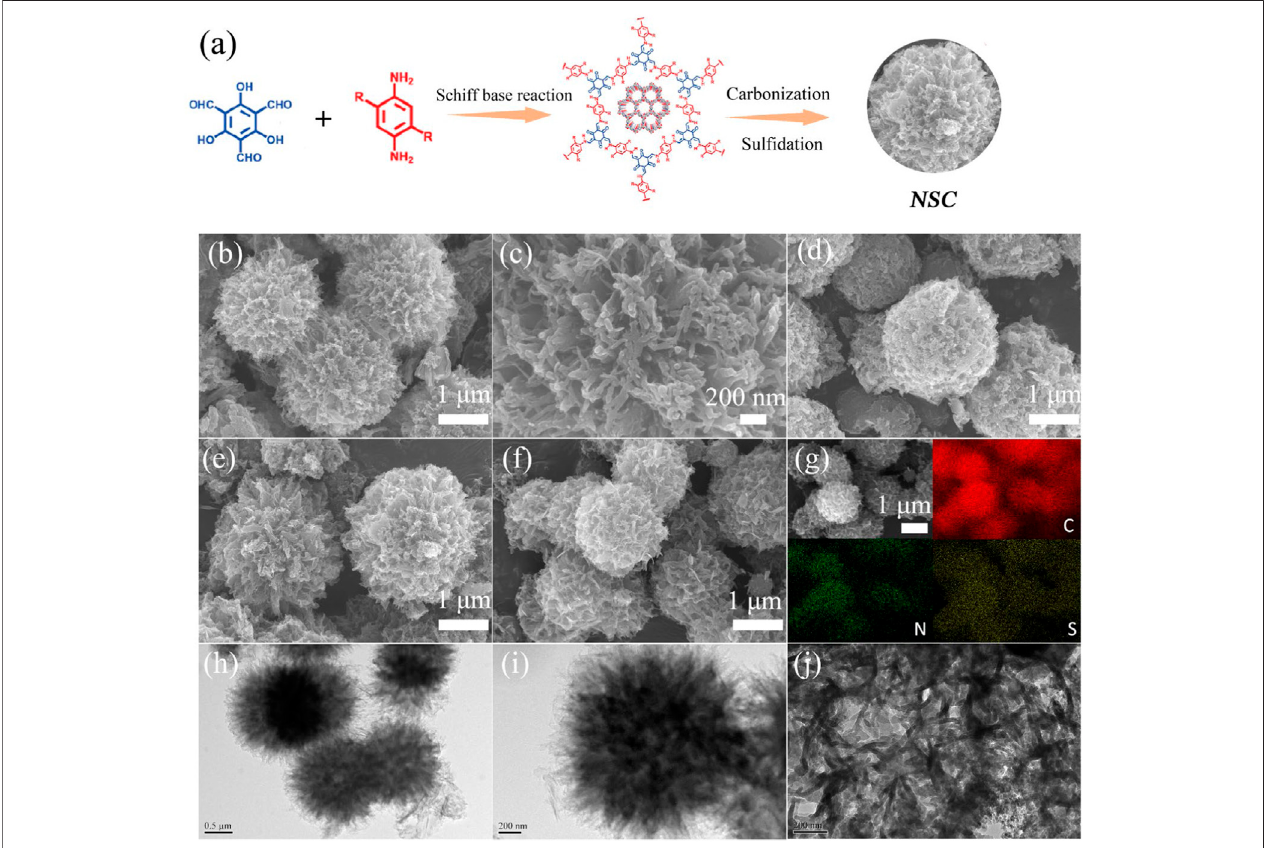
FIGURE 1 | Illustration of the conversion from as-prepared COFs to desired NSC (A) . FESEM images of pure COFs (B,C) , NSC-500 (D) , NSC-600 (E), and NSC- 700 (F) . Elemental mapping of NSC-600 (G) . TEM (H , I) and HRTEM (J) images of NSC-600.